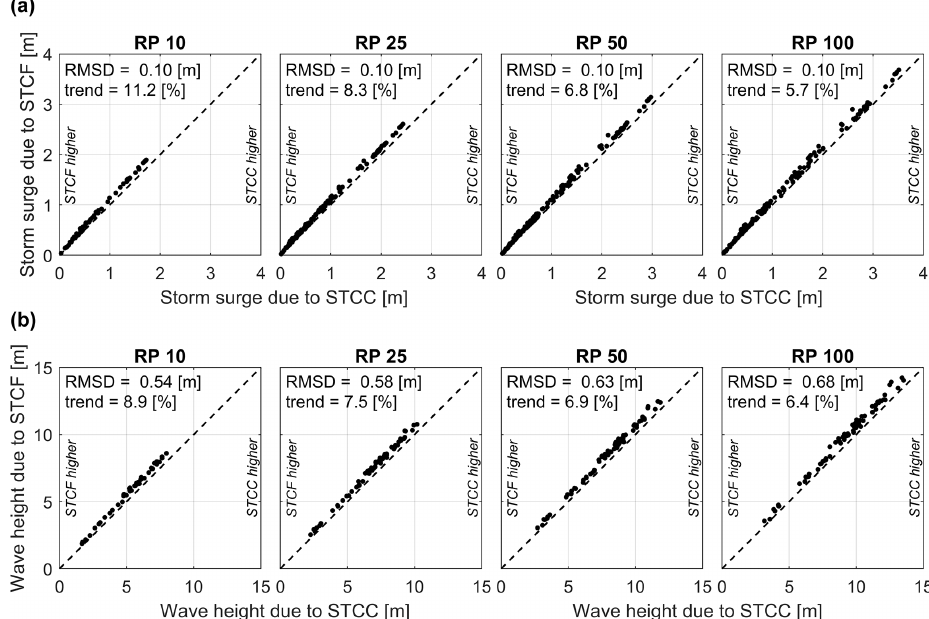
Figure B6. Scatterplots of computed storm surge (a) and wave heights (b) , both resulting from STCC ( x axis) and STCF ( y axis), for return periods of 10, 25, 50 and 100 years, for all locations along the Bay of Bengal. Root-mean-square differences (RMSDs) and the trend (%) of STCF compared to STCC are also